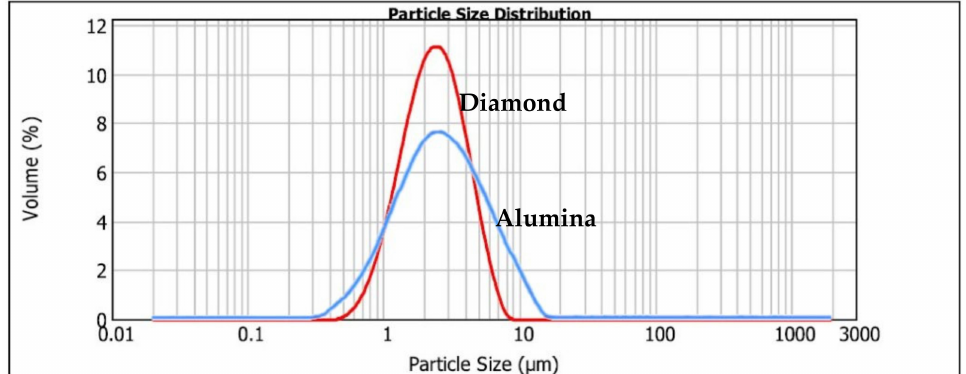
Figure 3. Distribution of the particles’ size regarding each type of abrasive particle: alumina 1 µ m, and diamond powder 1–2 µ